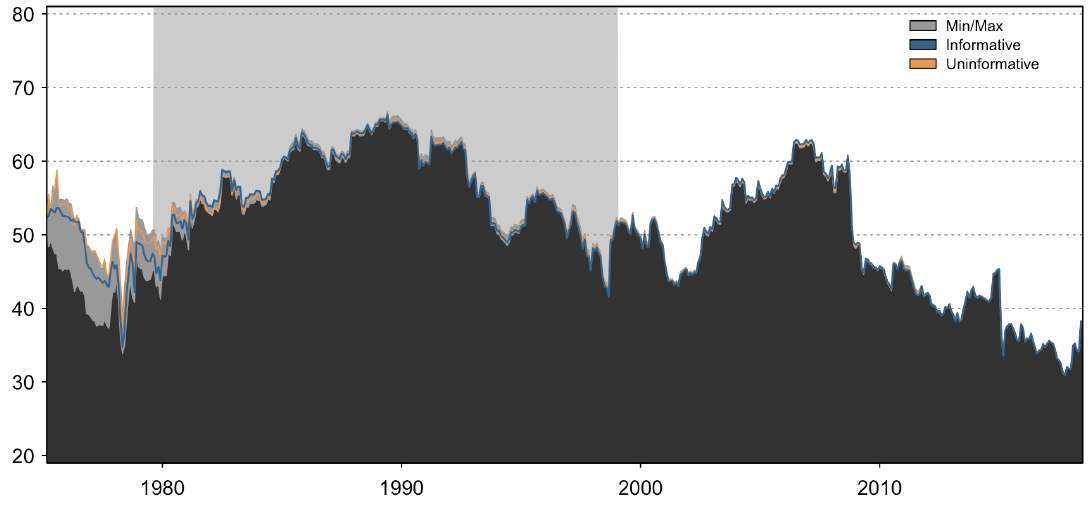
Figure 9. Prior sensitivity analysis: Dynamic total connectedness.